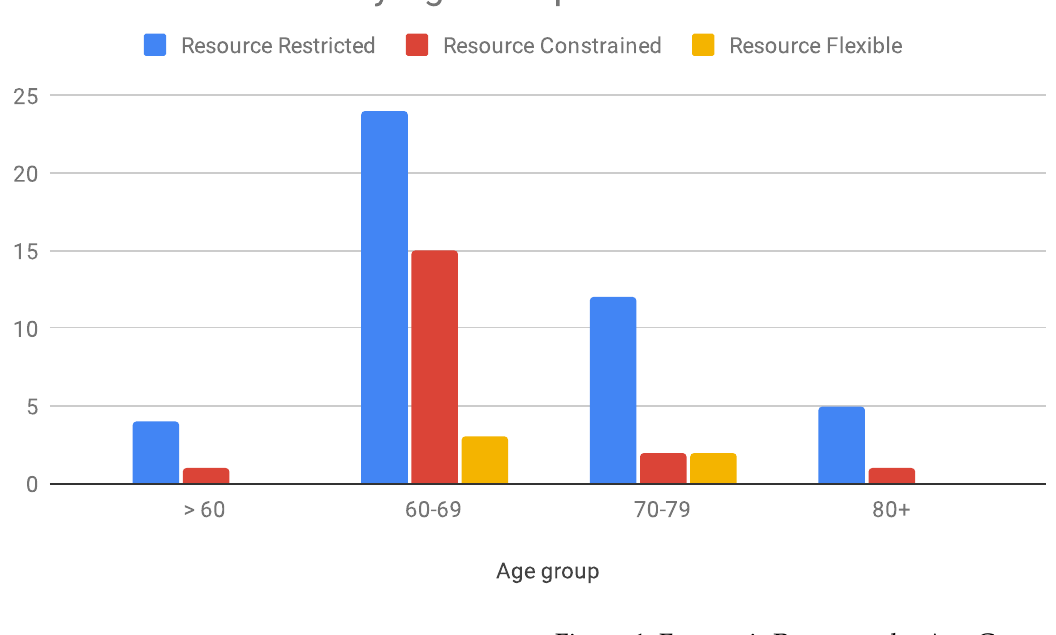
Figure 1: Economic Resources by Age